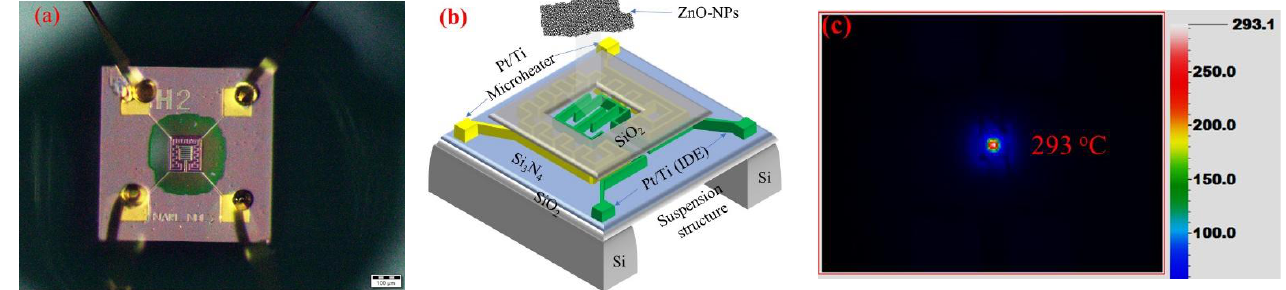
Figure 1. ( a ) The optical microscope, ( b ) the structure and ( c ) infrared thermal images of the ZnO- NPs/MEMS gas sensor. NPs/MEMS gas